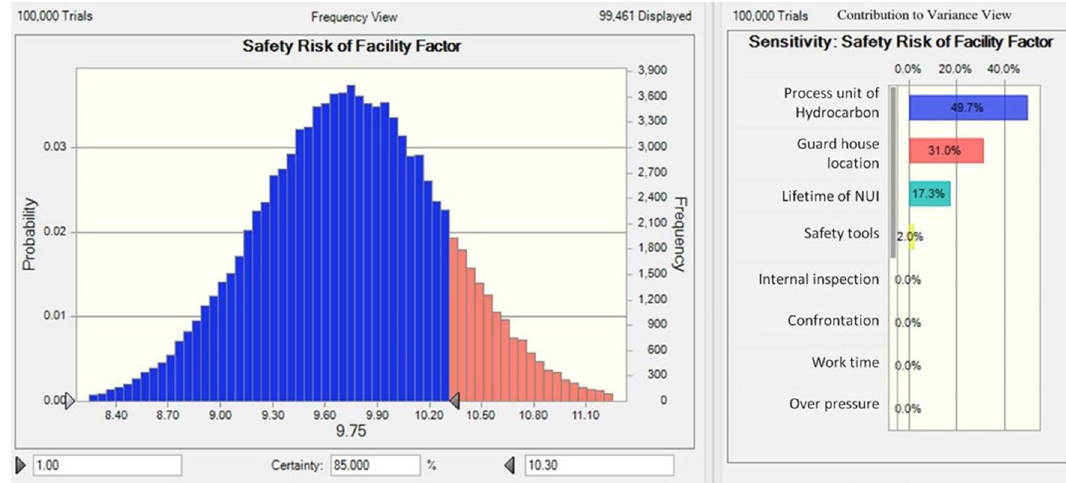
Fig. 1 Safety risk of the facility factor for a type A